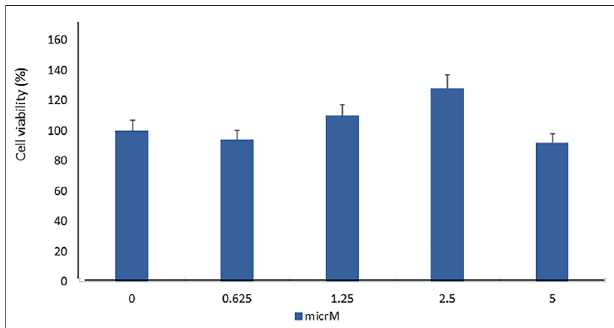
FIGURE 1 | Fisetin supplementation did not affect MSC viability in a statistically signi fi cant manner. The cell viability was evaluated by performing the XTT test in hMSCs cultured for 7 days in the presence of fi setin ranging from 0 to 5